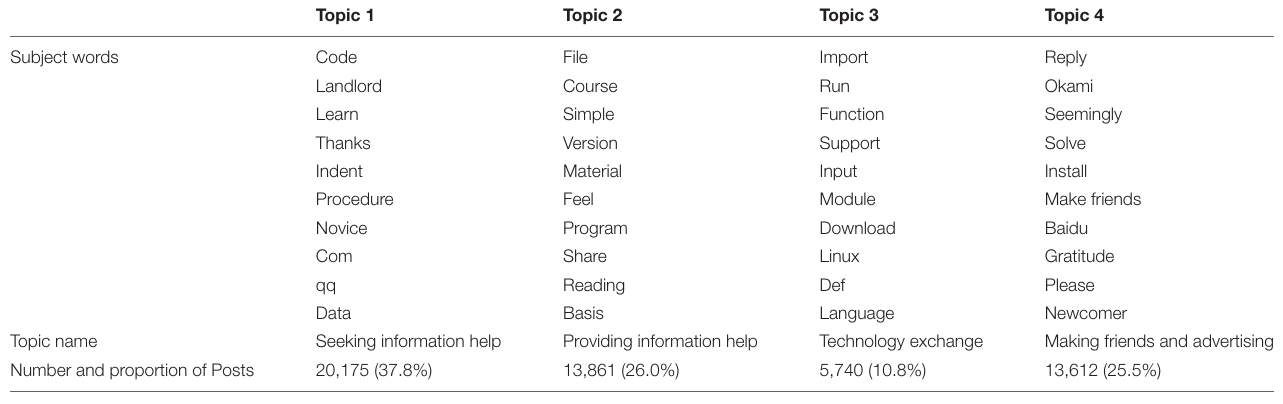
TABLE 3 | Male and female sentiment distribution results.